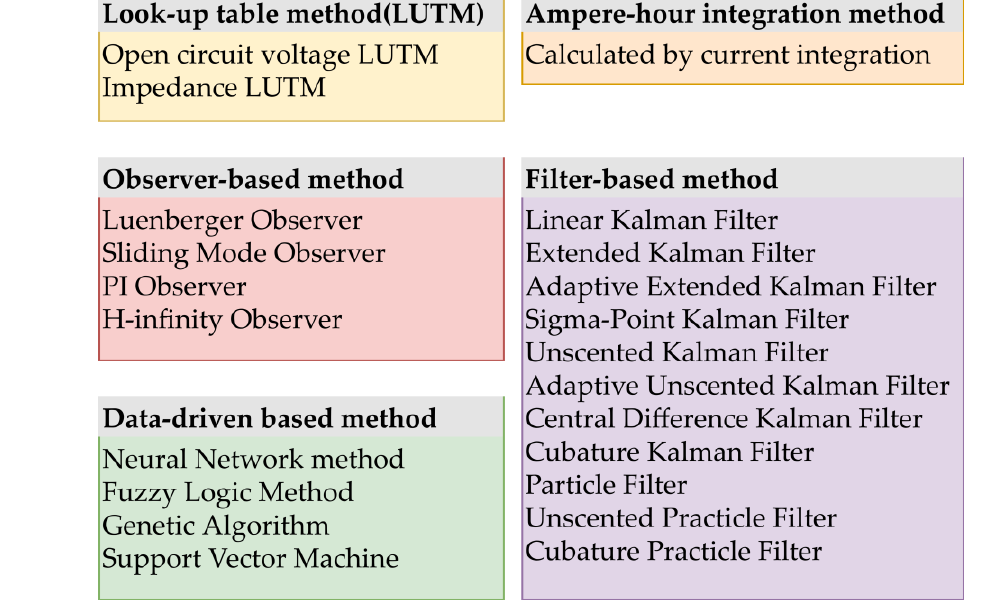
Figure 16. Different SOC estimation approaches.